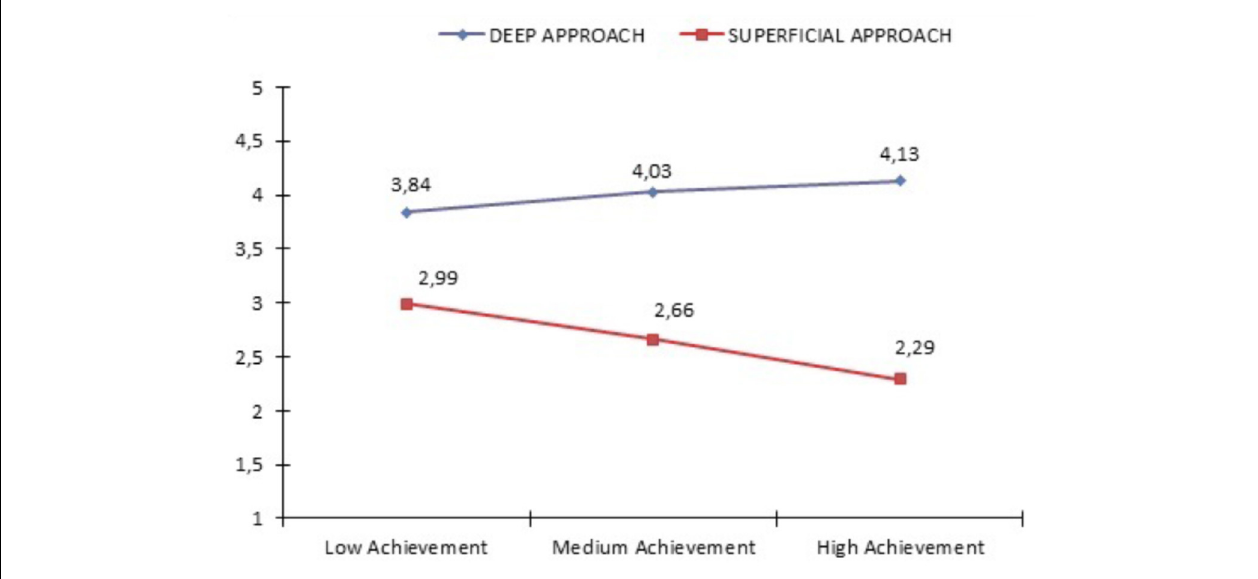
FIGURE 1 | Graphic representation of the mean values in motivational and cognitive engagement (deep approach, shallow approach) as a function of the levels of prior academic achievement.